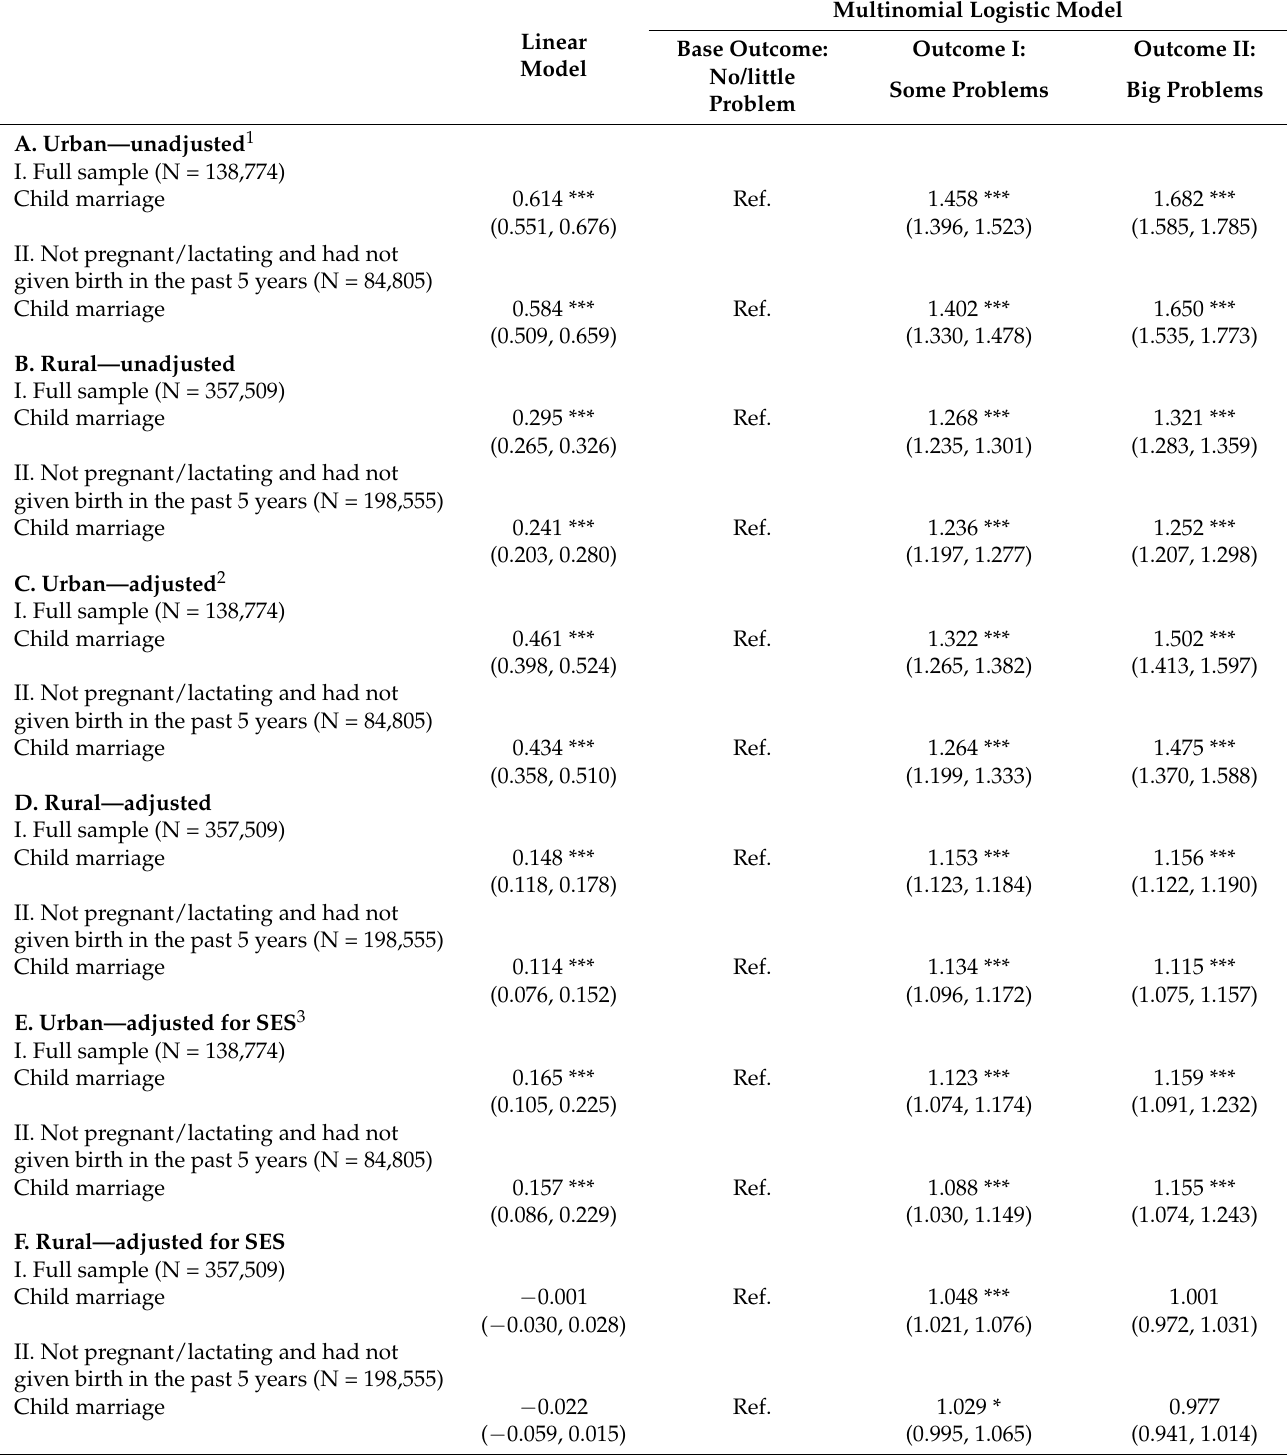
Table 6. Estimates of linear regression and relative risk ratios for facing problems accessing healthcare categorized by score—according to place of